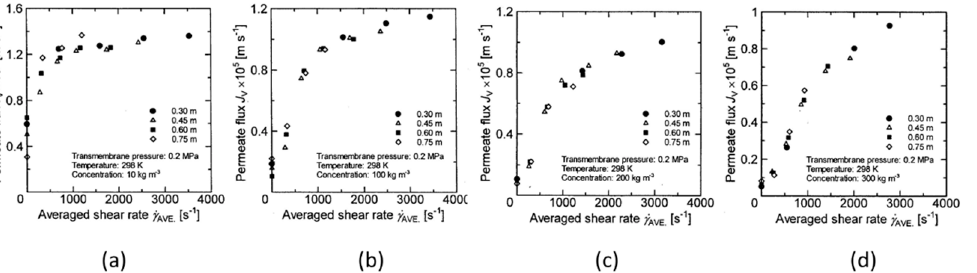
Figure 15. Relationship between average shear-rate and permeate flux when the TMP is 0.2 Mpa. ( a ) at latex concentration 10 kg/m 3 ( b ) 100 kg/m 3 ( c ) 200 kg/m 3 ( d ) 300 kg/m 3 .